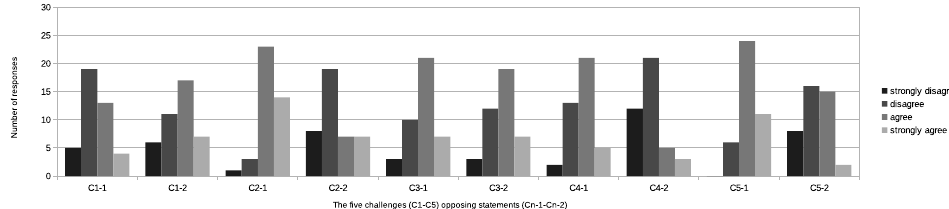
Figure 2. Clustered bar chart to show the attitudes towards the characteristics of identified solutions to the five challenges of agile risk management, aggregation of all respondents without filtering on experience.